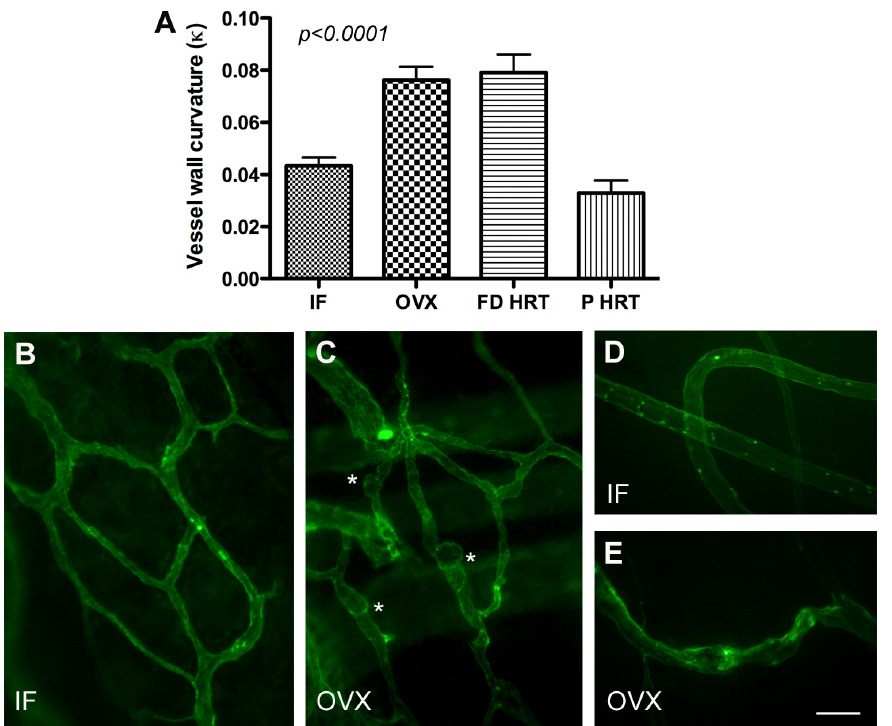
Figure 3. A, changes in microvessel wall intrinsic curvature in response to OVX, FD HRT, and P HRT. Data presented as mean 6 standard error of mean. B and C, Formation of multiple focal dilations/microaneurysms (asterisks) in DM microvasculature following OVX (C) compared to intact female (IF) animals (B). D and E, Reduced pericyte decoration of pig meningeal microvessels following OVX (E) compared with intact females (IF) animals (D) as revealed by fluorescent microscopy using mesenchymal progenitor marker SBA (Soybean Agglutinin).